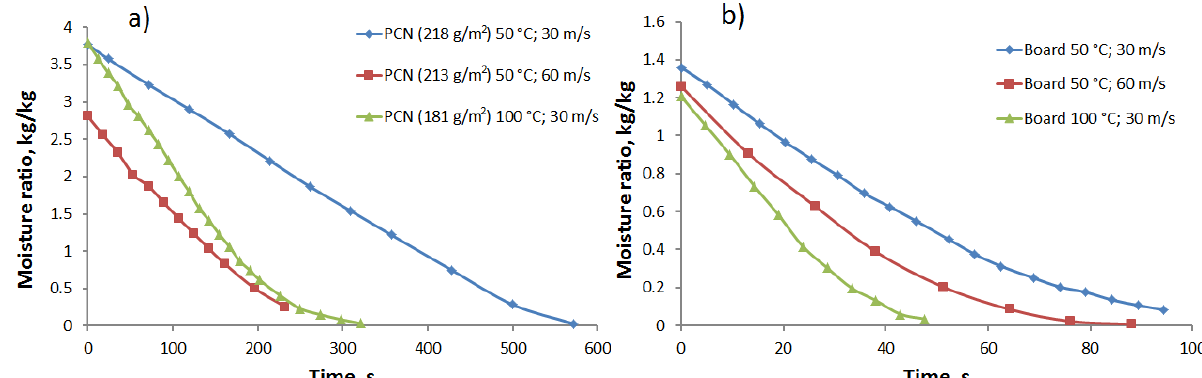
Figure 4. Drying curves for the air impingement drying for ( a ) PCN sheets and ( b ) the board at three different air speed and temperature